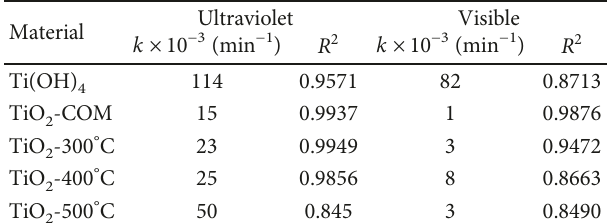
Table 3: Photocatalytic reaction constants of the AML degradation.